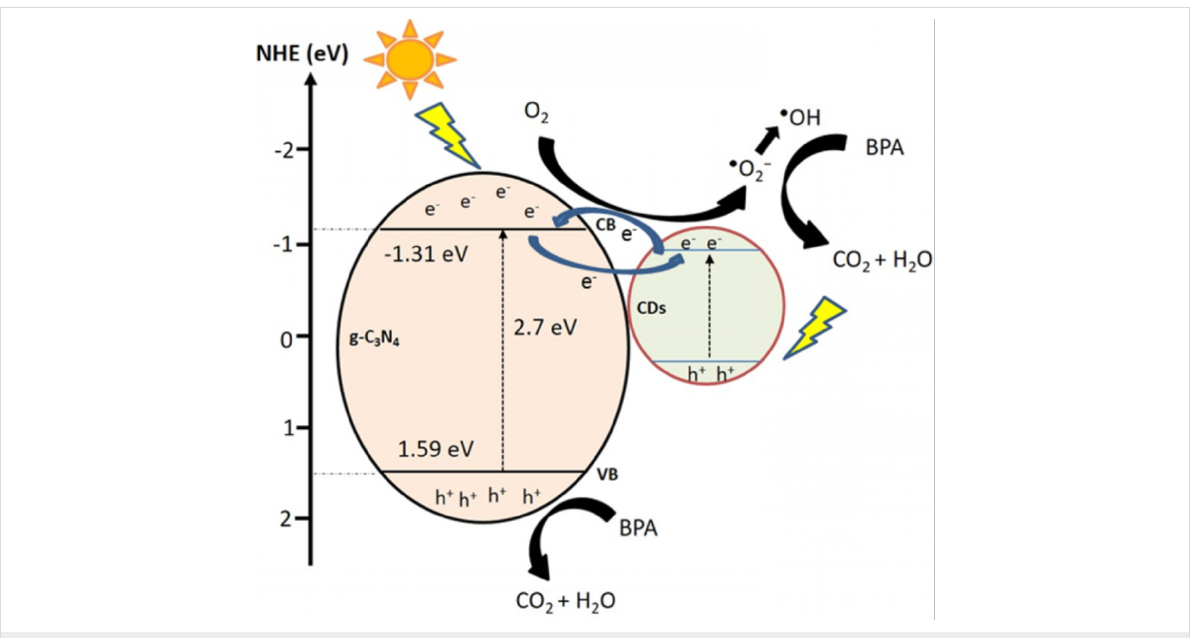
Figure 6: Electron transfer mechanism of CD/g-C 3 N 4